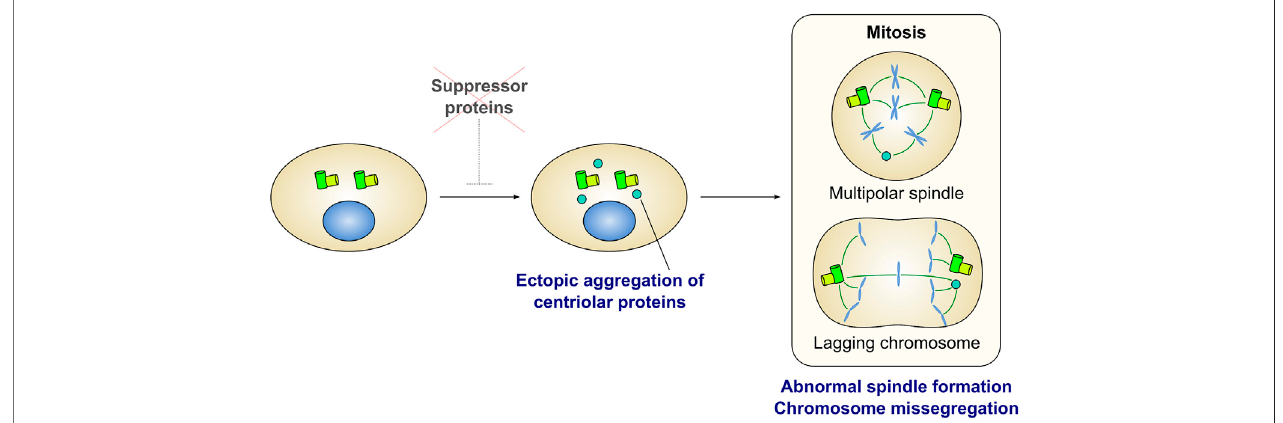
FIGURE 3 | Ectopic formation of centriolar protein aggregates is detrimental for cell division. Several proteins have been identi fi ed as a suppressor of ectopic aggregation of centriole-related proteins in the cytoplasm (also see Table 1 ). Depletion of the suppressors leads to form ectopic aggregates containing centriolar proteins. In many cases, aggregates can act as extra spindle poles and cause mitotic defects such as multipolar spindle formation and lagging chromosomes.